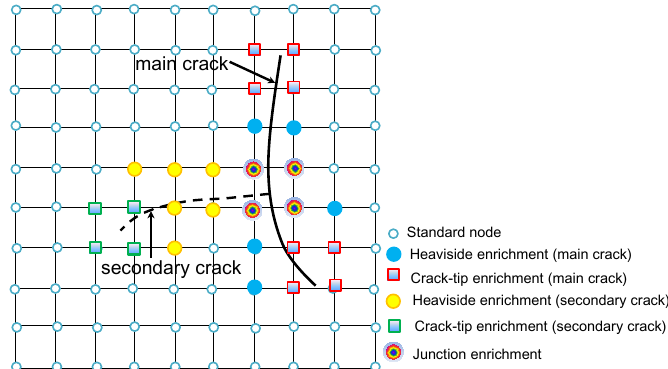
Figure 3. The discontinuous junction function for multiple